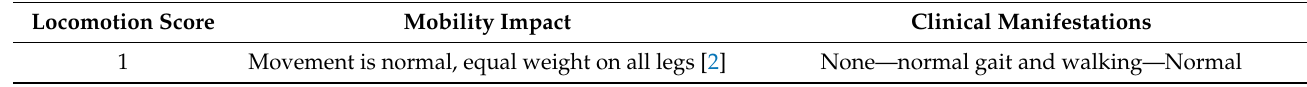
Table 1. Locomotion score system used as indicator of lameness in